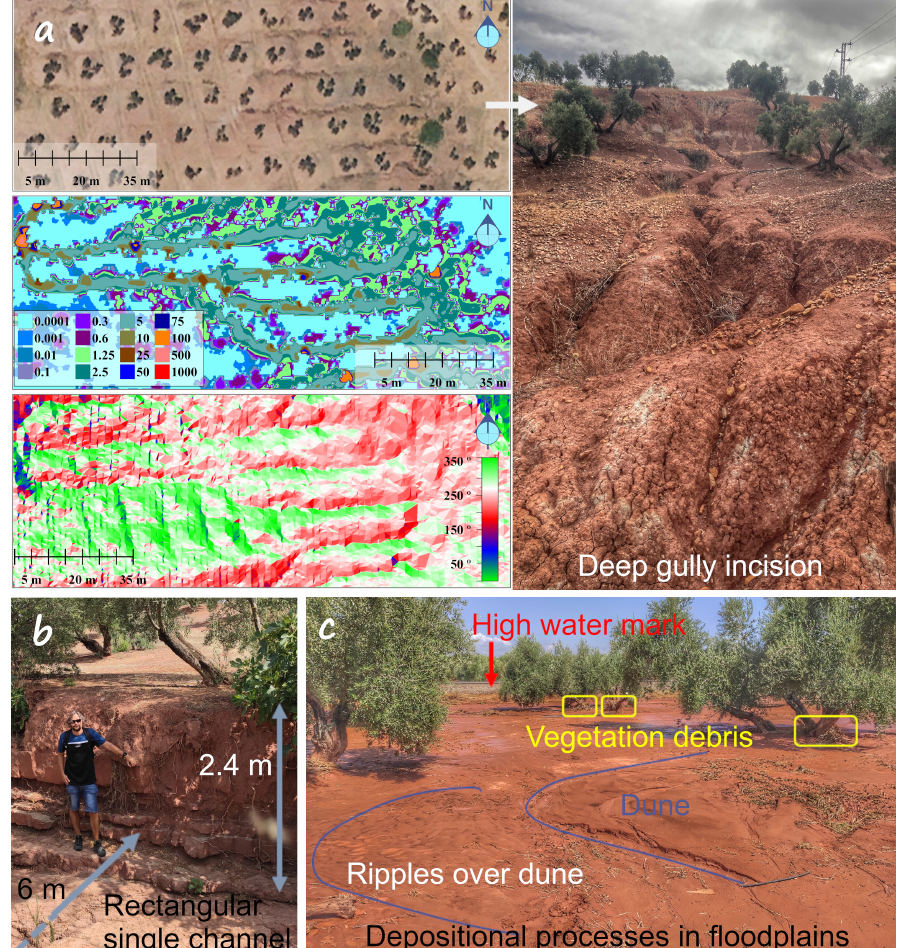
Figure 7. Examples of fluvial geomorphological features in the Manillas watershed that serve to verify the accuracy of the simulation CN89-A. ( a ) Gully network in the eastern headwater (red rectangle in Figure 6c): the left column shows a zoom of the shear-stress map, an orthophoto and the slope direction map for the DEM; the photo in the right-hand-side depicts an upstream view of the existing gullies. ( b ) Confined single-thread channel eroded in a rocky bed due to high shear stresses. ( c ) Paleostage indicators of flood levels and bedforms developing in unconfined flow on a floodplain. Photographs b and c were taken in the locations marked with the red and yellow dots in Figure 1a few meters downstream and upstream of the cross between the Manillas stream and the road,